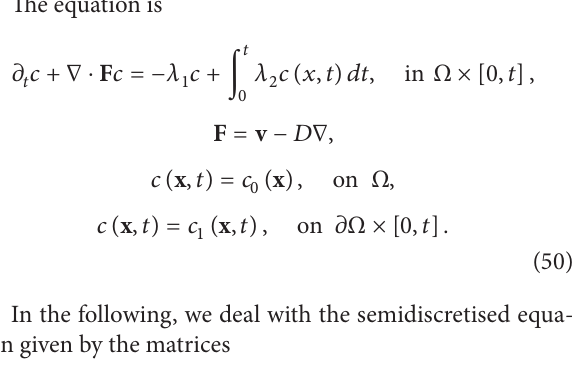
Figure 6: The computational time of the one-sided and two-sided splitting schemes for an optimised approach: one-sided splitting over 𝐴 (a) and two-sided splitting scheme alternating between 𝐴 and 𝐵 (b) with 1,...,6 iterative steps. The equation